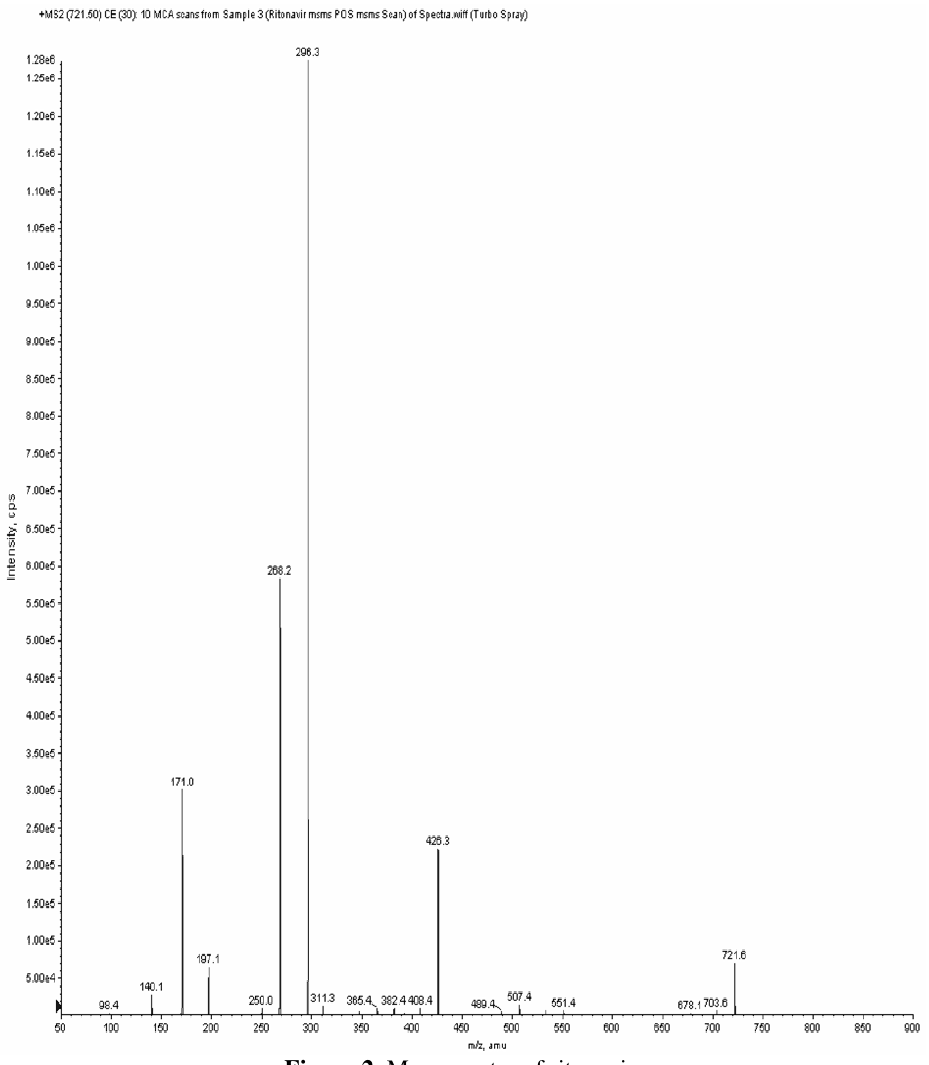
Figure 2. Mass spectra of